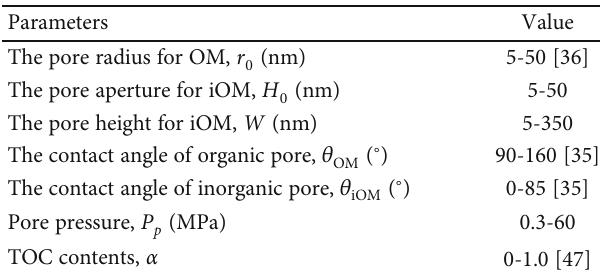
Figure 4: Validation of the proposed model for gas transport through inorganic pores. Table 2: Numerical values of parameters used in the model ’ s sensitivity